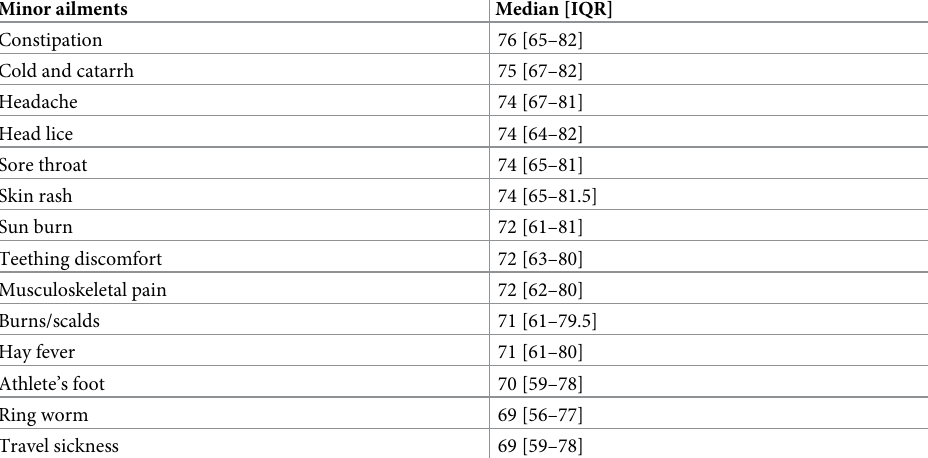
Table 2. Community pharmacists’ self-perceived competency to manage each of the common 14 minor ailments in Qatar (maximum obtainable score per minor ailment =